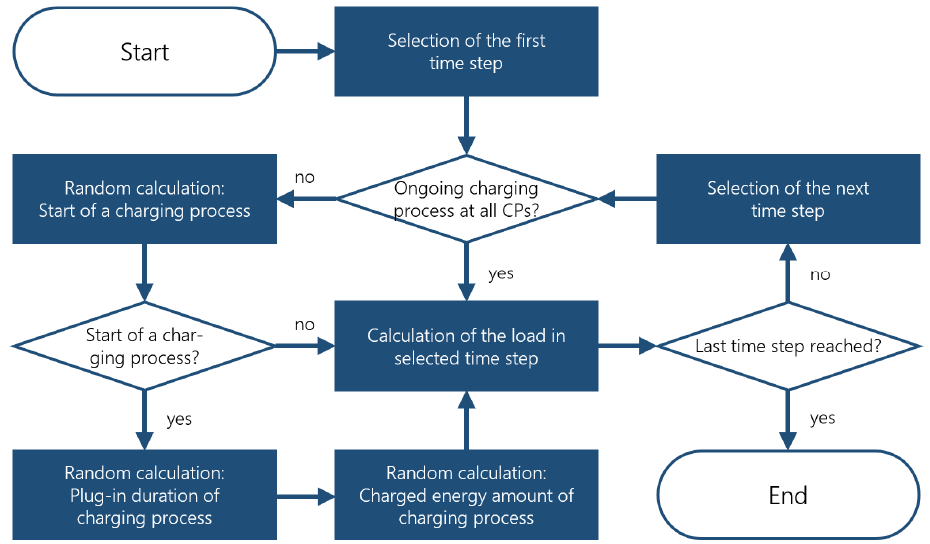
Figure 13. Flowchart of the basic process for generating load profiles. After initialization, the module follows the sequence and calculates the load profile for each CP and time step. The calculation distinguishes between plug-in time and charging time, since vehicles can be fully charged before plug-in time has elapsed. Maintenance charges within the plugged-in period after full charge is reached are neglected.